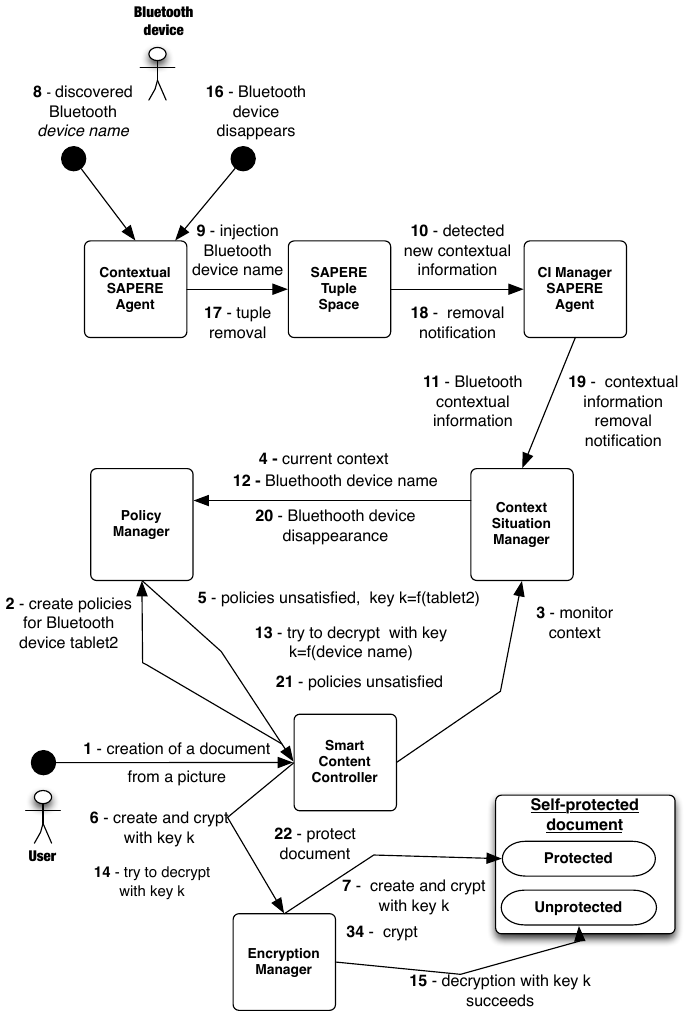
Figure 6. Transitions for the system in the first